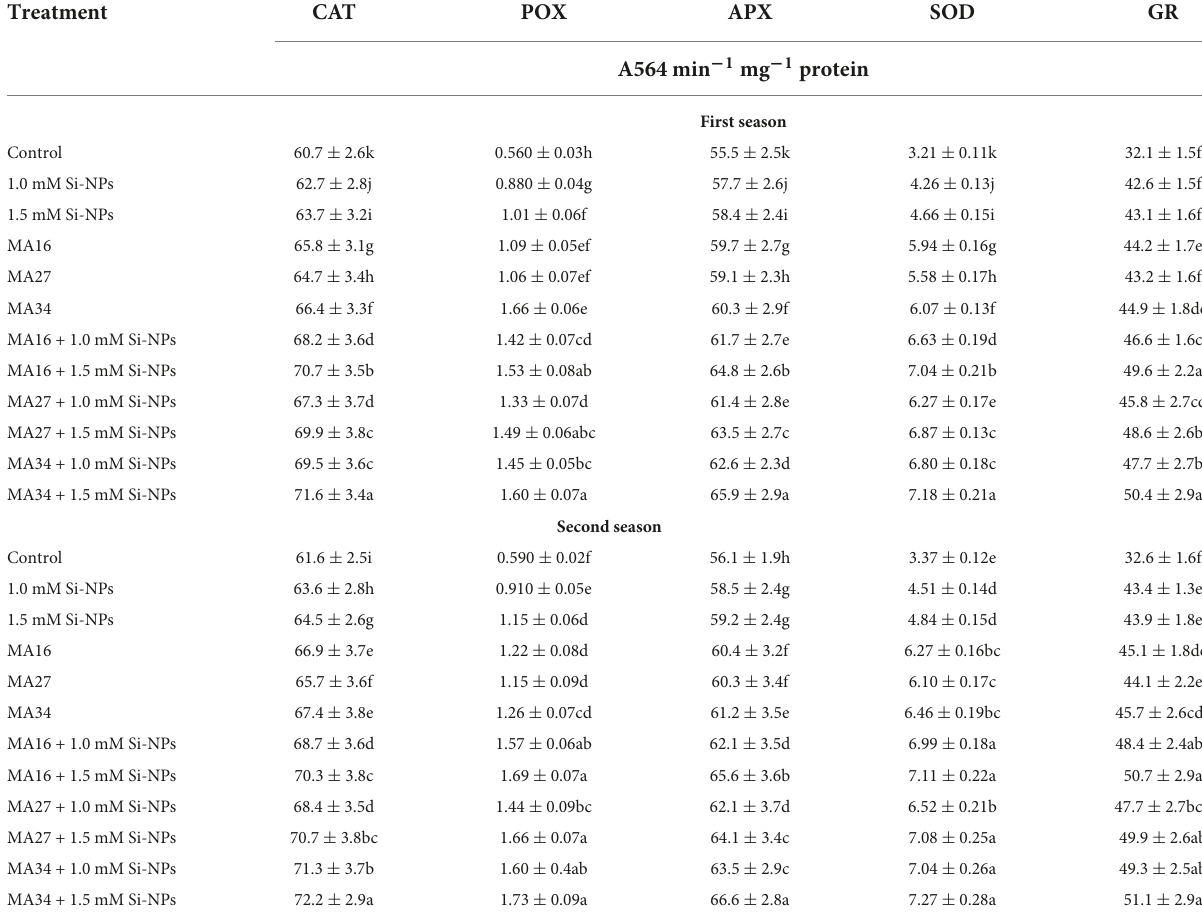
TABLE 7 Effect of soil application with calcium carbonate precipitating bacteria (CCPB), Bacillus lichenforms (MA16), Bacillus megaterium (MA27), and Bacillus subtilis (MA34), and foliar application with silicon nanoparticles (Si-NPs) on antioxidant enzymes of wheat plants (cv. Misr 2).